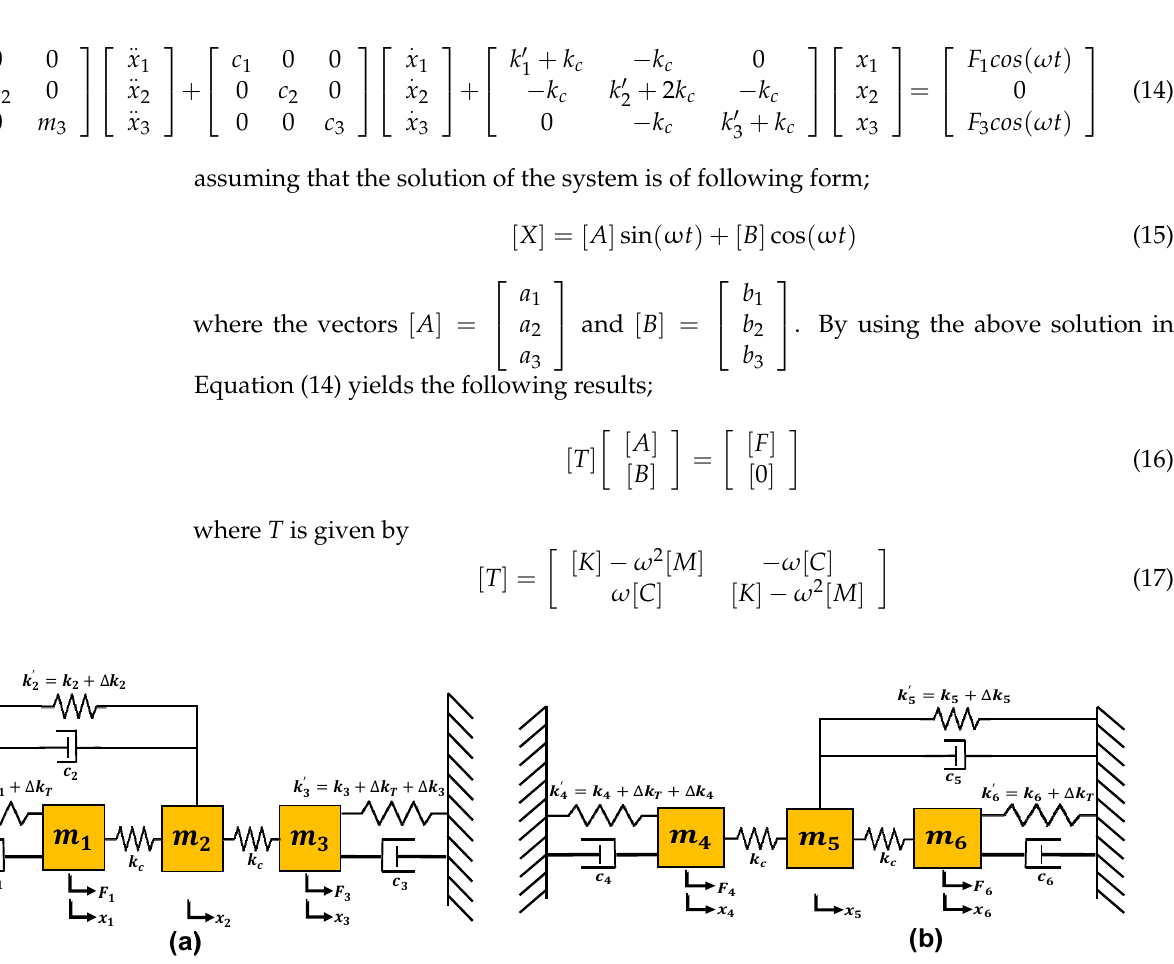
Figure 2. Lumped mass-spring-damper model of the 3-DoF weakly coupled MEMS resonators ( a ) Set A ( b ) Set B. After A and B are found by using Equation (16), the frequency of the (cid:1861) (cid:3047)(cid:3035) resonator